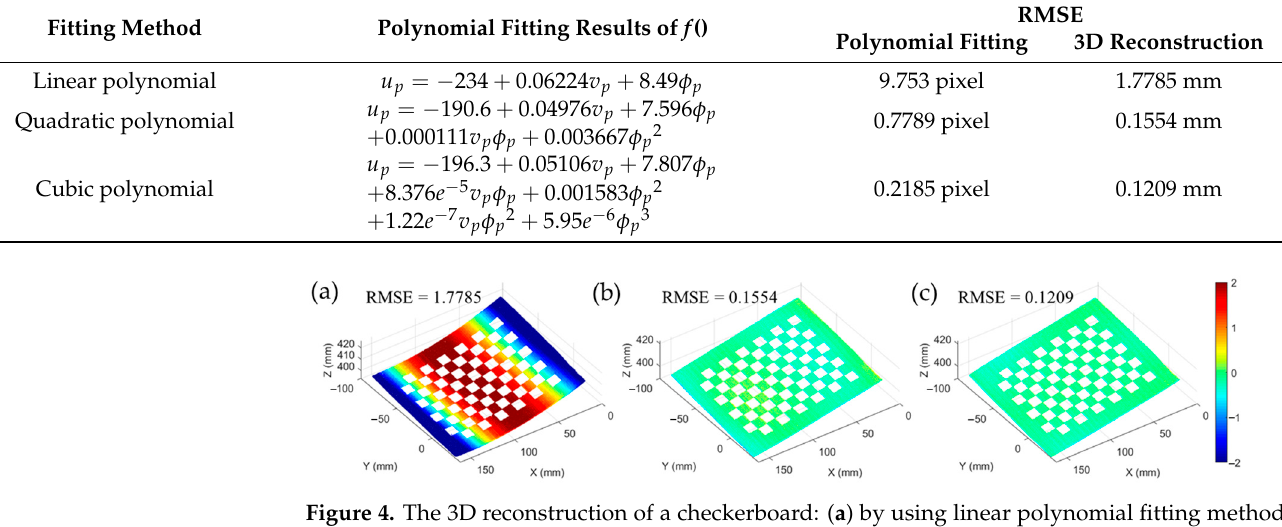
Figure 4. The 3D reconstruction of a checkerboard: ( a ) by using linear polynomial fitting method, ( b ) by using quadratic polynomial fitting method, and ( c ) by using cubic polynomial fitting method. Table 1. Polynomial fitting results with different fitting methods.